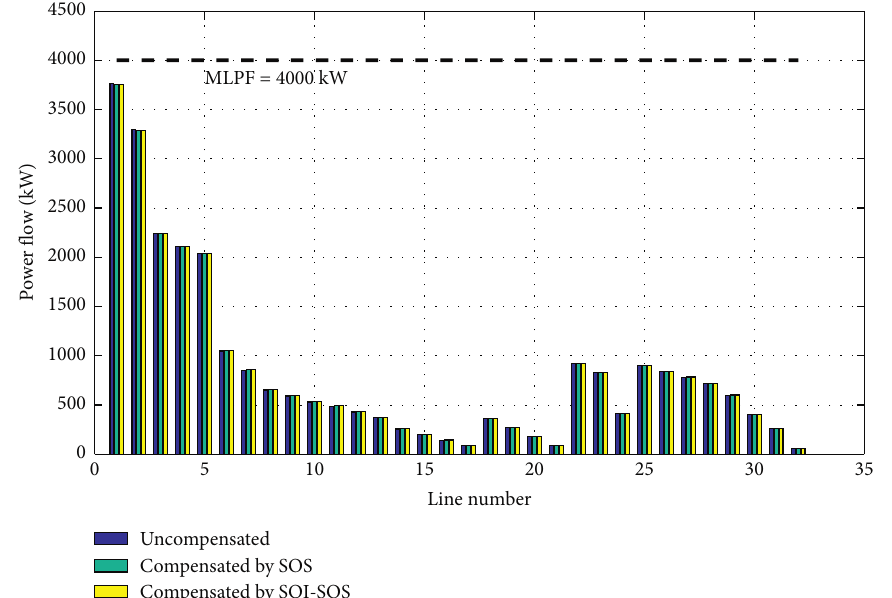
Figure 8: Comparison of lines power flow of the 33-bus system before and after compensation with the mixed load model. Table 8: Optimal locations and kVArs of capacitors for the 33-bus system with different load models. Load